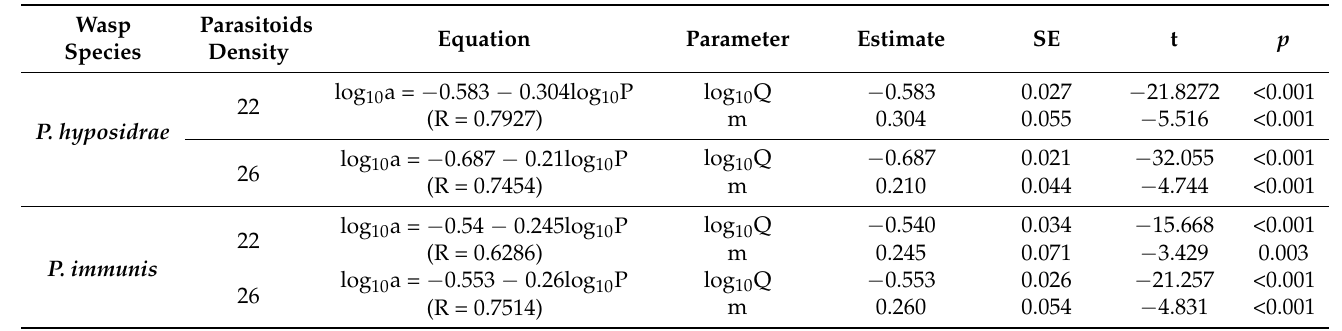
Table 4. Regression equation of mutual interference for Pr. immunis and Pa. hyposidrae at 22 ◦ C and 26 ◦